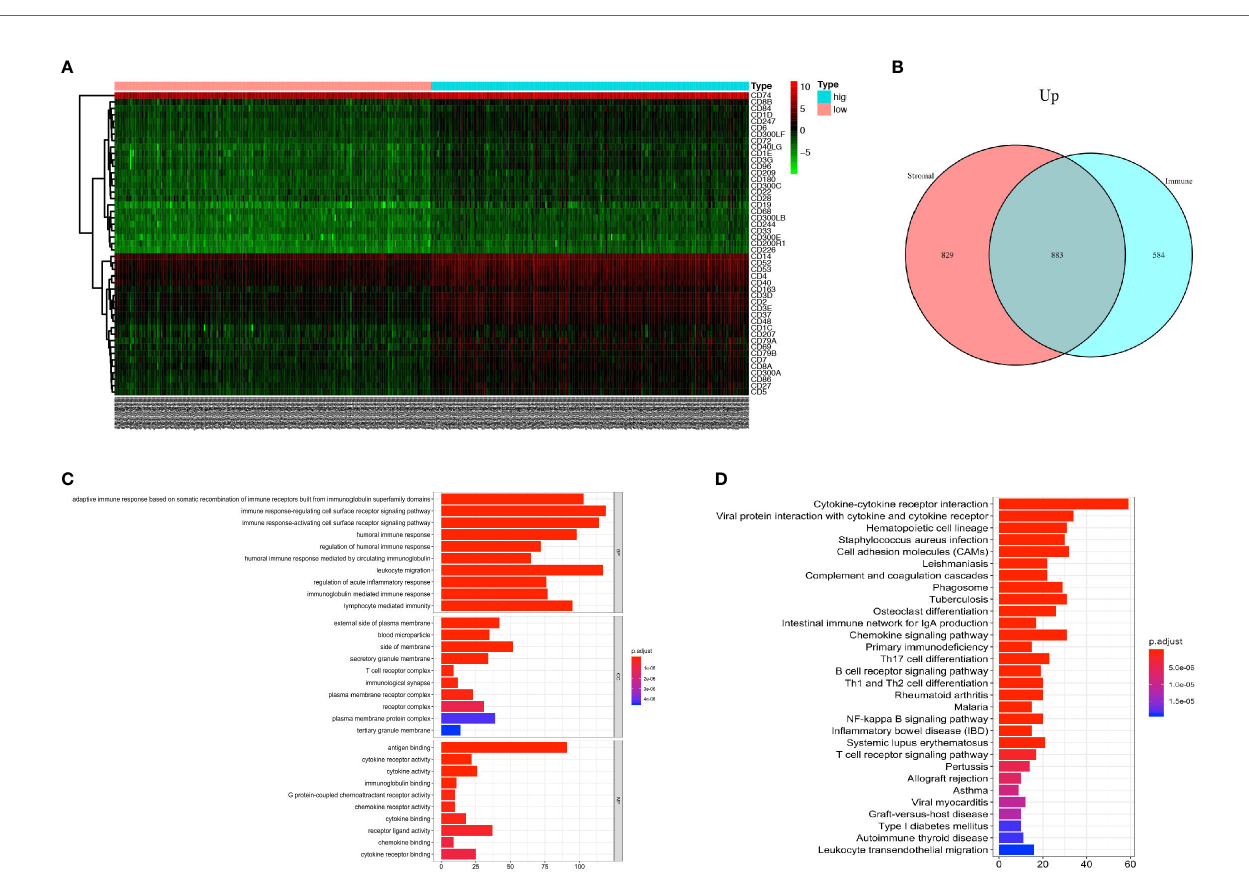
FIGURE 2 | PCa patients with higher immune score have more immune cell in fi ltration and more activated immune responses. (A) Heatmap of the CD markers gene expression levels between the immune score high group and low group ( P < 0.05, Fold Change>2). (B) The number of commonly upregulated genes in immune score high group and stromal score high group shown by Venn diagram. (C) Top 10 GO terms, including BP, CC, and MF, respectively, enriched according to the commonly upregulated genes ( P < 0.05). (D) Top 20 KEGG terms enriched according to the commonly upregulated genes ( P <